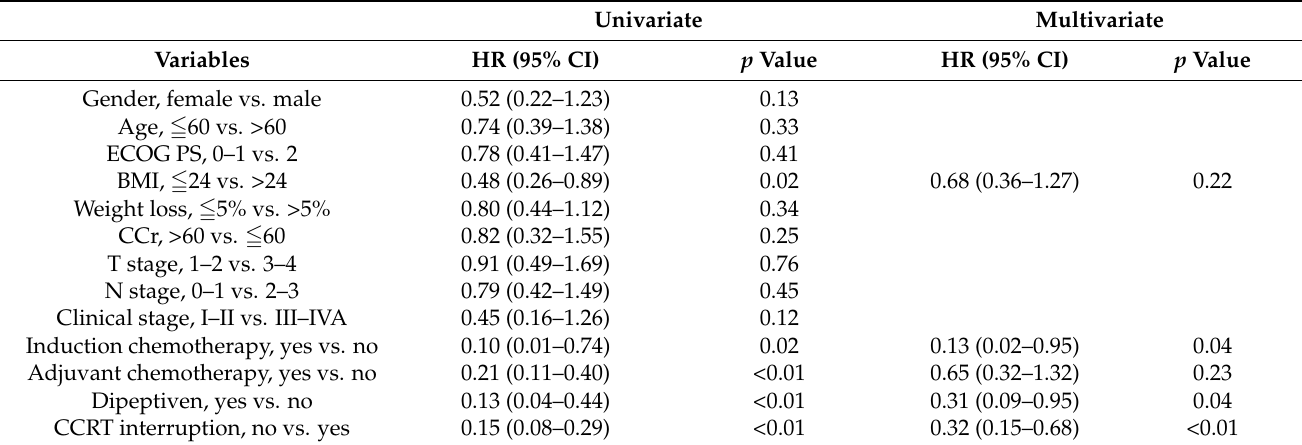
Table 3. Cox regression analysis of parameters associated with overall survival. Univariate Multivariate